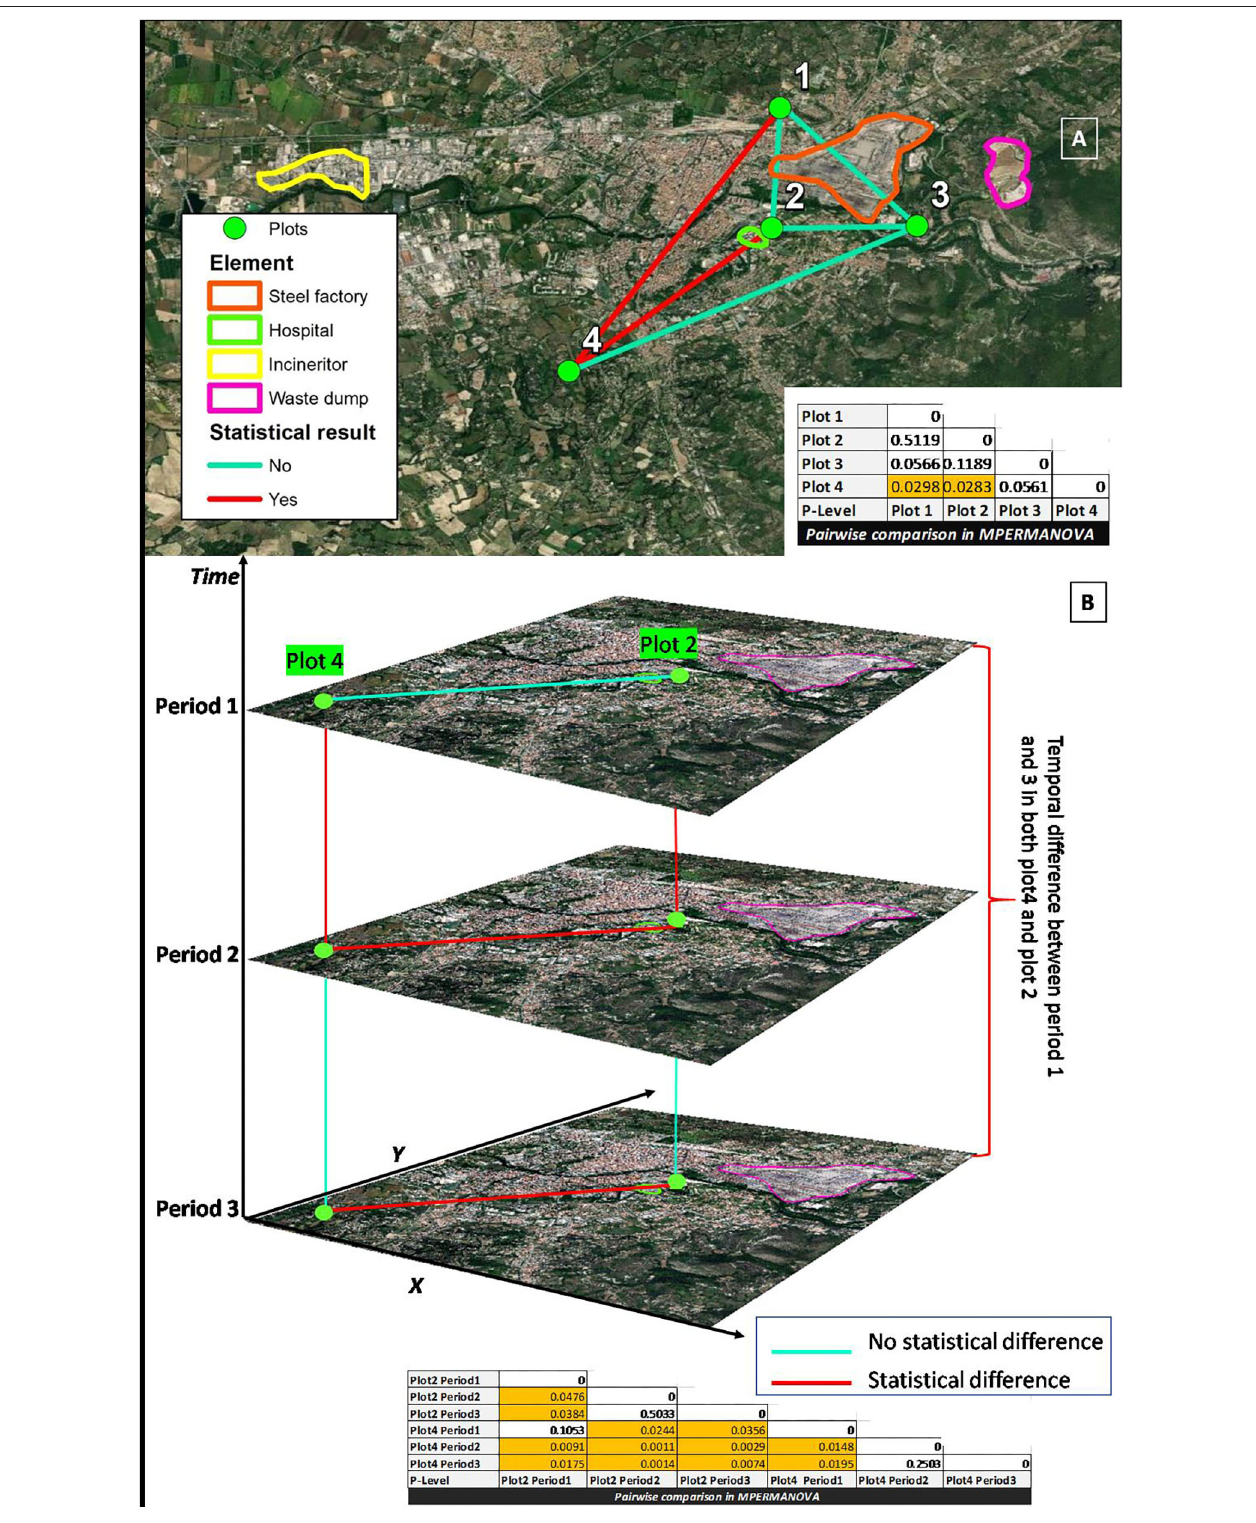
FIGURE 2 | PERMANOVA analysis: P -values of pairwise comparisons of the conceptual model in Figure 1 . (A) Representation of the significance differences between plot1, plot2, plot3 and plot4, and (B) representation of the significant differences between period1, period2 and period3 in plot2 and plot4, that are chosen as comparable. The orthophotos used to represent the statistical results in the time and in the space are derived from Bing-Maps.